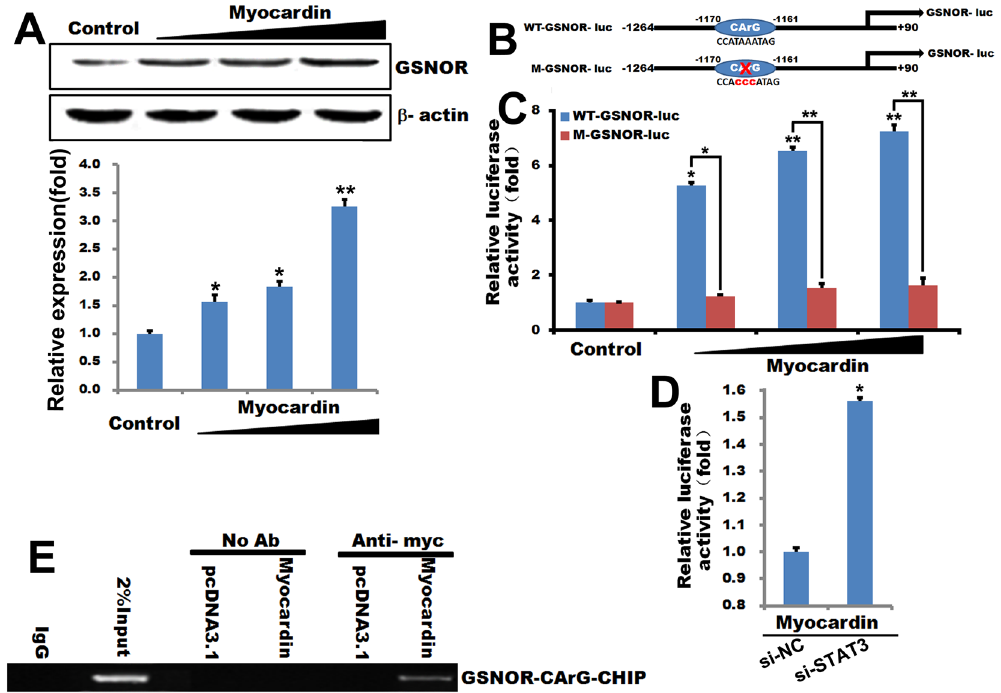
Figure 4. Myocardin-mediated GSNOR transactivation is dependent on the CArG box. ( A ) Western blot analysis of GSNOR protein level in T/G HA-VSMC cells transfected with Myocardin at the indicated dosages for 24 hours and quantified the western blot data by Quantity One software. β -actin is a loading control. ** p < 0.01, * p < 0.05. n = 3. ( B ) The GSNOR promoter ( − 1264 to + 90) containing CArG box element was linked to a luciferase reporter vector (WT-GSNOR-luc). The M-GSNOR-luc represents a luciferase reporter vector including mutated-CArG box GSNOR promoter. ( C ) T/G HA-VSMC cells were transfected with WT-GSNOR-luc or M-GSNOR-luc, together with Myocardin or pcDNA3.1 vector for 24 hours. Then the luciferase reporter assays were used to test the transactivity of GSNOR. The data represent mean ± SEM. ** p < 0.01, * p < 0.05. n = 6. ( D ) T/G HA-VSMC cells were transfected with WT-GSNOR-luc, together with si-control orsi-STAT3 in stabled expression Myocardin VSMCs for 24 hours. Then the luciferase reporter assays were used to test the transactivity of GSNOR. The data represent mean ± SEM. * p < 0.05. n = 6. ( E ) T/G HA-VSMC cells were transiently transfected with Myc- Myocardin or a control vector (pcDNA3.1) for 24 hours, and ChIP assays were performed. Sheared DNA/protein complexes were immunoprecipitated by using an anti-Myc antibody (Ab). Then, PCR was carried out to detect the endogenous CArG regions in immunoprecipitated chromatin fragments. The amount of DNA in each sample (input) is shown at the second land. Immunoprecipitations were performed without primary antibody (no Ab) and IgG as a negative. The 2% input and H4 were used as positive